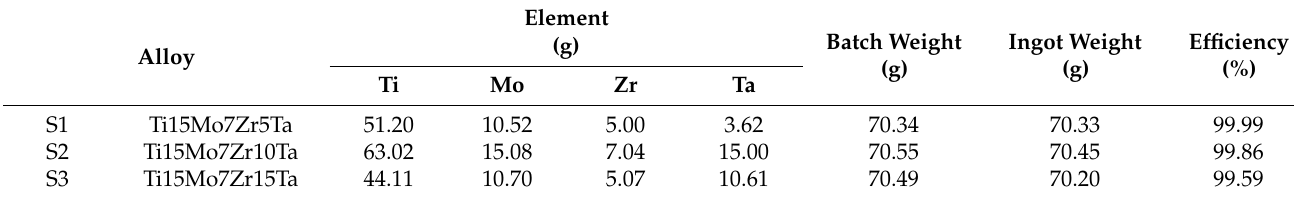
Table 1. Metallic load for the experimental substrate alloys.